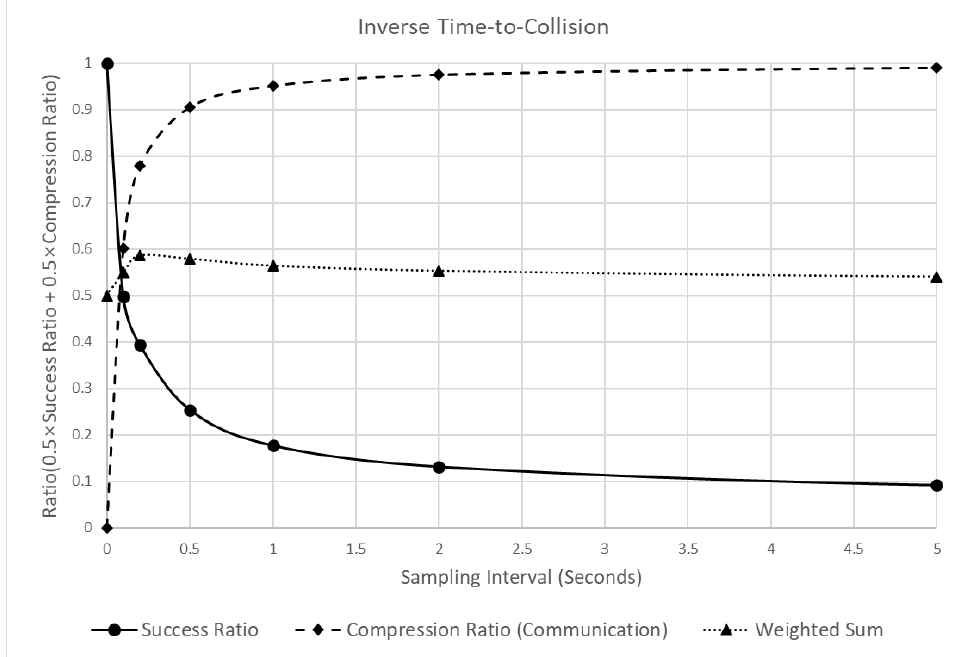
Figure 16. Analysis of the detection success ratio, compression ratio, and a weighted sum of the ITTC, varying the sampling intervals. varying the sampling